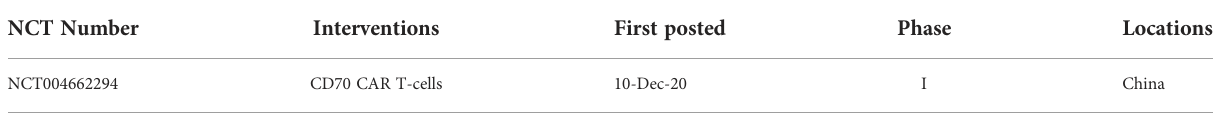
TABLE 7 Recruiting CD70 CAR clinical